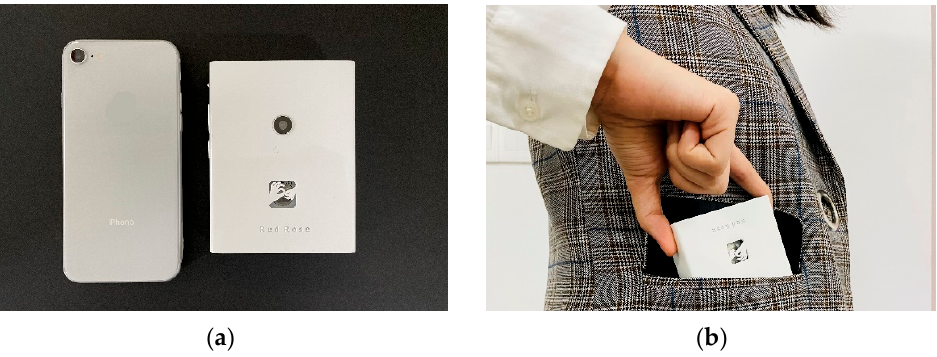
Figure 5. ( a ) Size comparison between Heart-Speaker and mobile phone; ( b ) Heart-Speaker’s port- ability demonstration as it can be carried in a jacket pocket.